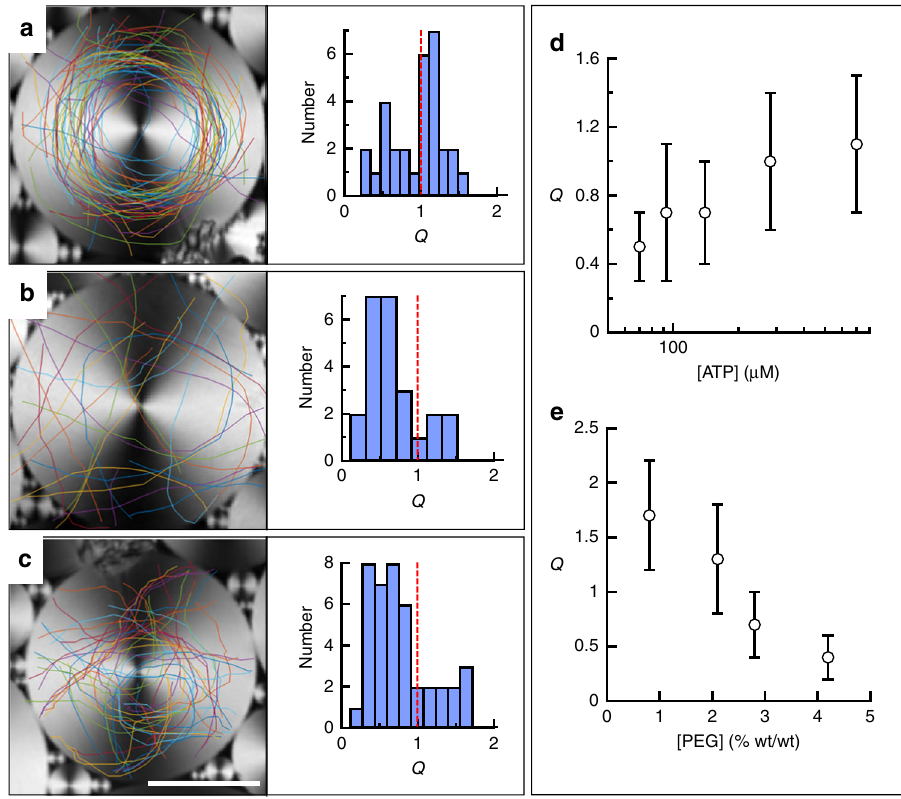
Fig. 3 Soft con fi nement of the active nematic. Confocal re fl ection micrographs of different TFCDs and overlaid trajectories of +1/2 defects of the fl owing AN for different experimental conditions: a [ATP] = 700 µ M, [PEG] = 0.8% (wt/wt); b [ATP] = 70 µ M, [PEG] = 0.8% (wt/wt); c [ATP] = 700 µ M, [PEG] = 4.2% (wt/wt). Histograms next to micrographs include the distribution of measured winding numbers, Q . Scale bar 25 µ m. Each line color corresponds to the trajectory of a different defect (Supplementary Movie 3). d Average value and standard deviation of Q for domains with diameter 60 μ m, [PEG] = 1.6% (wt/wt), and different values of [ATP]. e Average value and standard deviation of Q for domains with diameter 60 μ m, [ATP] = 1.4 mM, and different values of [PEG]. Error bars are the standard deviation for the measurements under each